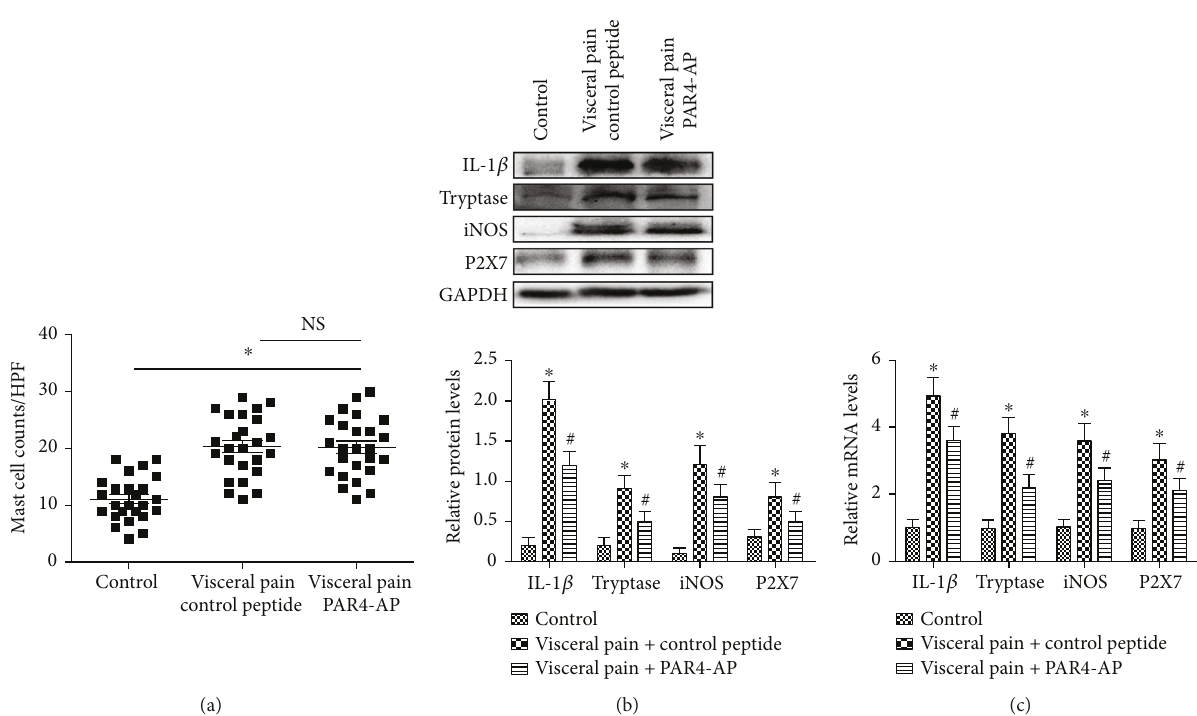
Figure 3: E ff ects of PAR4-AP on the expressions of tryptase, iNOS, P2X7, and IL-1 β in the colons of visceral hyperalgesia rats. (a) Graph showing the numbers of tryptase- (AA1-) positive MCs in the colonic mucosae of the visceral hyperalgesia rats that were treated with PAR4-AP or control peptide ( n = 25 ). HPF: high-power fi eld. NS: no statistical signi fi cance. (b) The tryptase, iNOS, P2X7, and IL-1 β protein levels were assessed by Western blotting. The mean optic densities of the protein were calculated by normalizing to GADPH. (c) The relative levels of tryptase, iNOS, P2X7, and IL-1 β mRNA were measured by quantitative real-time PCR (qRT-PCR). The results were calculated by normalizing to β -actin in the same sample with the Δ Ct method. The data are presented as the mean ± SEM ( n = 3 ), ∗ P < 0 05 versus controls; # P < 0 05 versus the control peptide